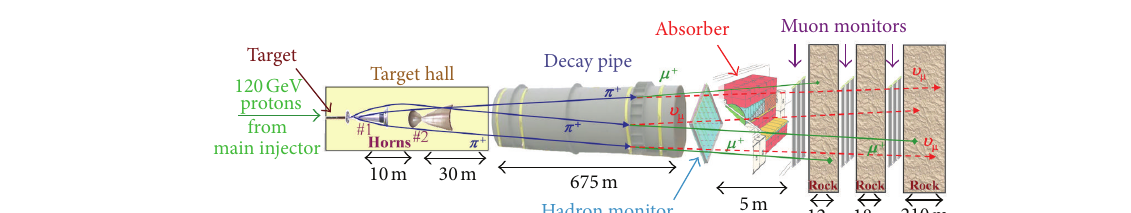
Figure 3: Simulated neutrino flux of K2K beam.